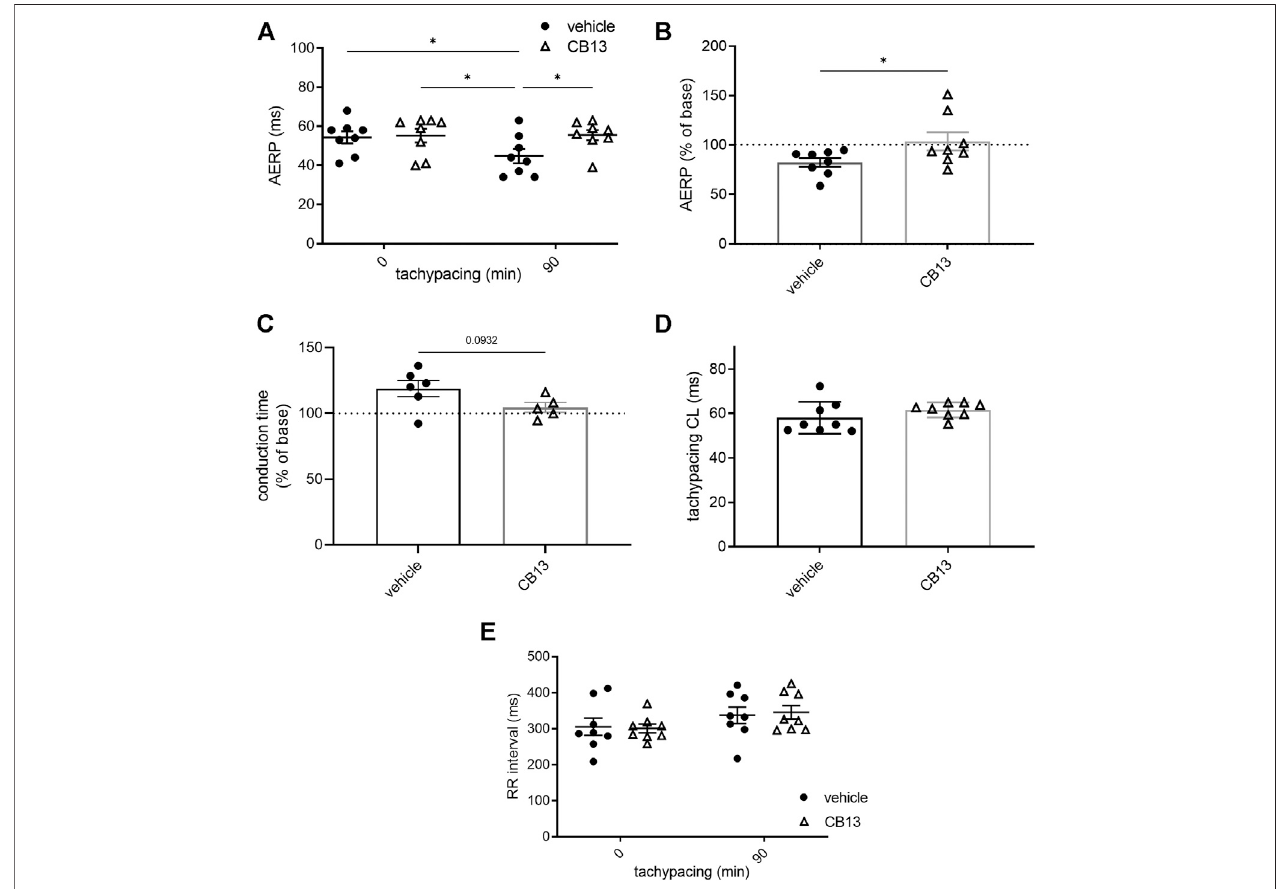
FIGURE 3 | CB13-treatment inhibited tachypacing-induced atrial electrical remodeling. (A) AERP before and after 90 min of atrial tachypacing; (B) Scatter plot demonstrating the effect of atrial tachypacing on the AERP represented as % of baseline value in each experiment. CB13 treatment prevented reduction in AERP following tachypacing. (C) Conduction time analysis demonstrated a trend of lengthening in vehicle treated tachypaced hearts relative to the CB13 treated hearts. (D) Average pacing CL over the 90 min of atrial tachypacing. The CL was adjusted continuously and maintained 5 ms above the minimal CL to maintain 1:1 atrial capture. Note no difference between the CB13 group and vehicle group in this regard. (E) Spontaneous RR interval measured before and after 90 min of atrial tachypacing in both groups. Note a mild tendency of RR interval prolongation which reached signi fi cance in the CB13 group only. n (cid:1) 5 – 8 for each group. Data are presented as mean ± SEM. * p ≤ 0.05. CL, cycle length; AERP, atrial effective refractory period. Based on the normality test statistical signi fi cance was determined using two-way ANOVA with Newman-Keuls test for multiple comparisons (A,E) , Mann-Whitney test (B)